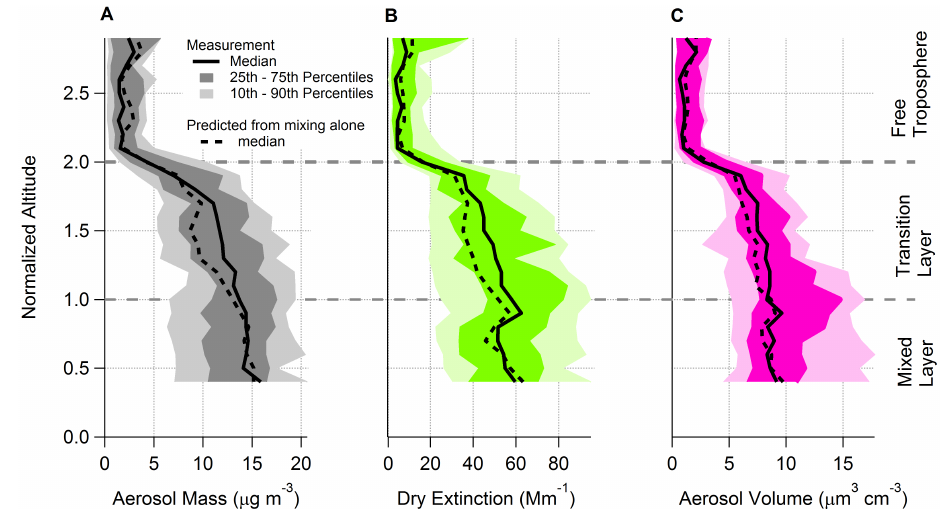
Figure 9. Altitude-normalized aggregate profiles of aerosol mass (a) , extinction (b) , and volume (c) . The aerosol volume was calculated from measured particle size distributions. The shaded regions show the interdecile range (light) and the interquartile range (medium), and the solid lines are the median (dark). The dashed line shows the median value expected from mixing alone (Eq. 3). The difference between the observed median value and the median value expected from mixing alone indicates an enhancement of aerosol in the transition